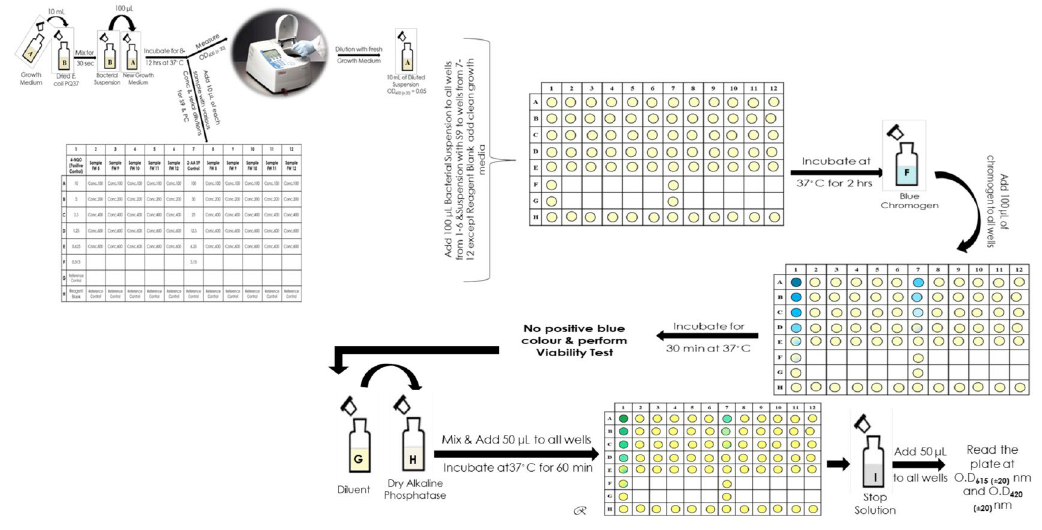
Fig. 3. Genotoxicity / Mutagenicity Experimental NPs Categories, Size, Solvents Percentage and Titanium Precursor Concentration Table 1. TiO 2 TiO NPs Categories 2